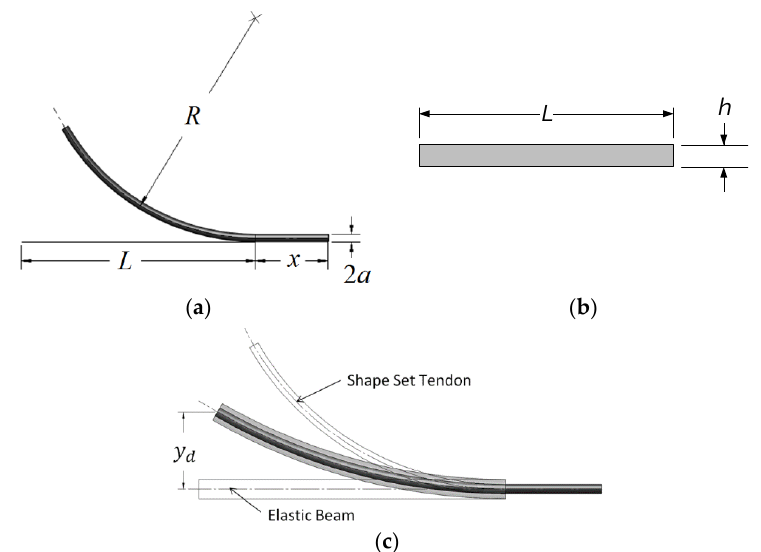
Figure 3. ( a ) Shape-set SMA tendon, ( b ) elastic sleeve, ( c ) composite flexural micro-actuator.